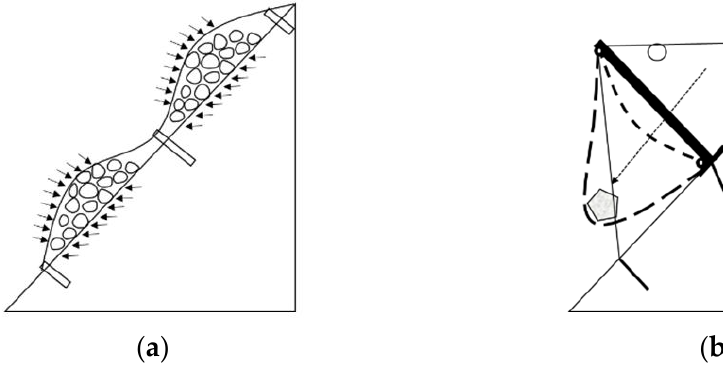
Figure 2. Different load patterns: ( a ) quasi-static load; ( b ) dynamic load.